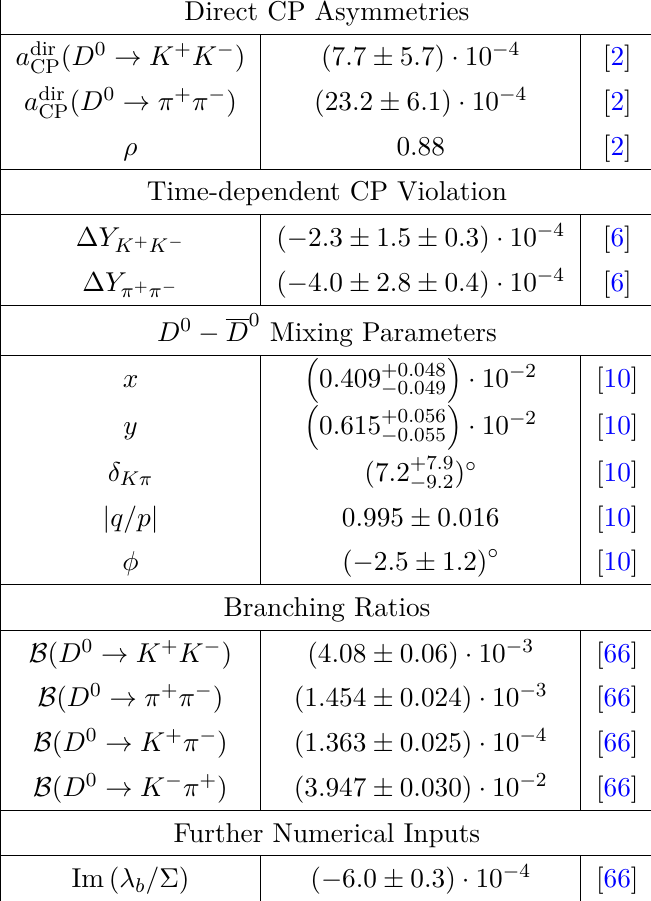
Table 1 . Experimental input data. We include the correlation between a dir ( D 0 → π + π − ) which is given by ρ . We also include the correlations between the mixing a dir CP parameters x , y , δ , | q/p | , and φ , which are given in table 2. We symmetrize all errors of the input Kπ